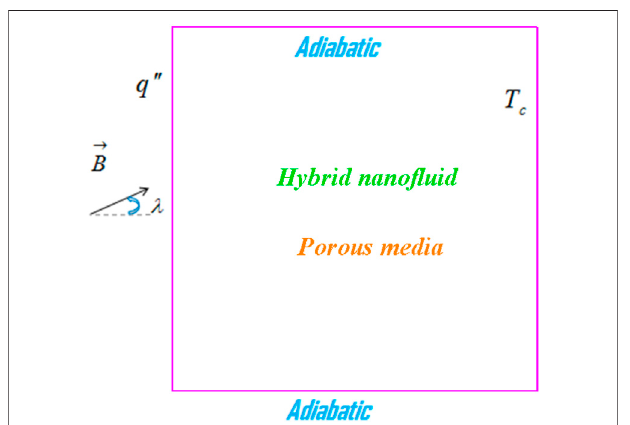
FIGURE 1 | Porous zone with considering heat fl ux.